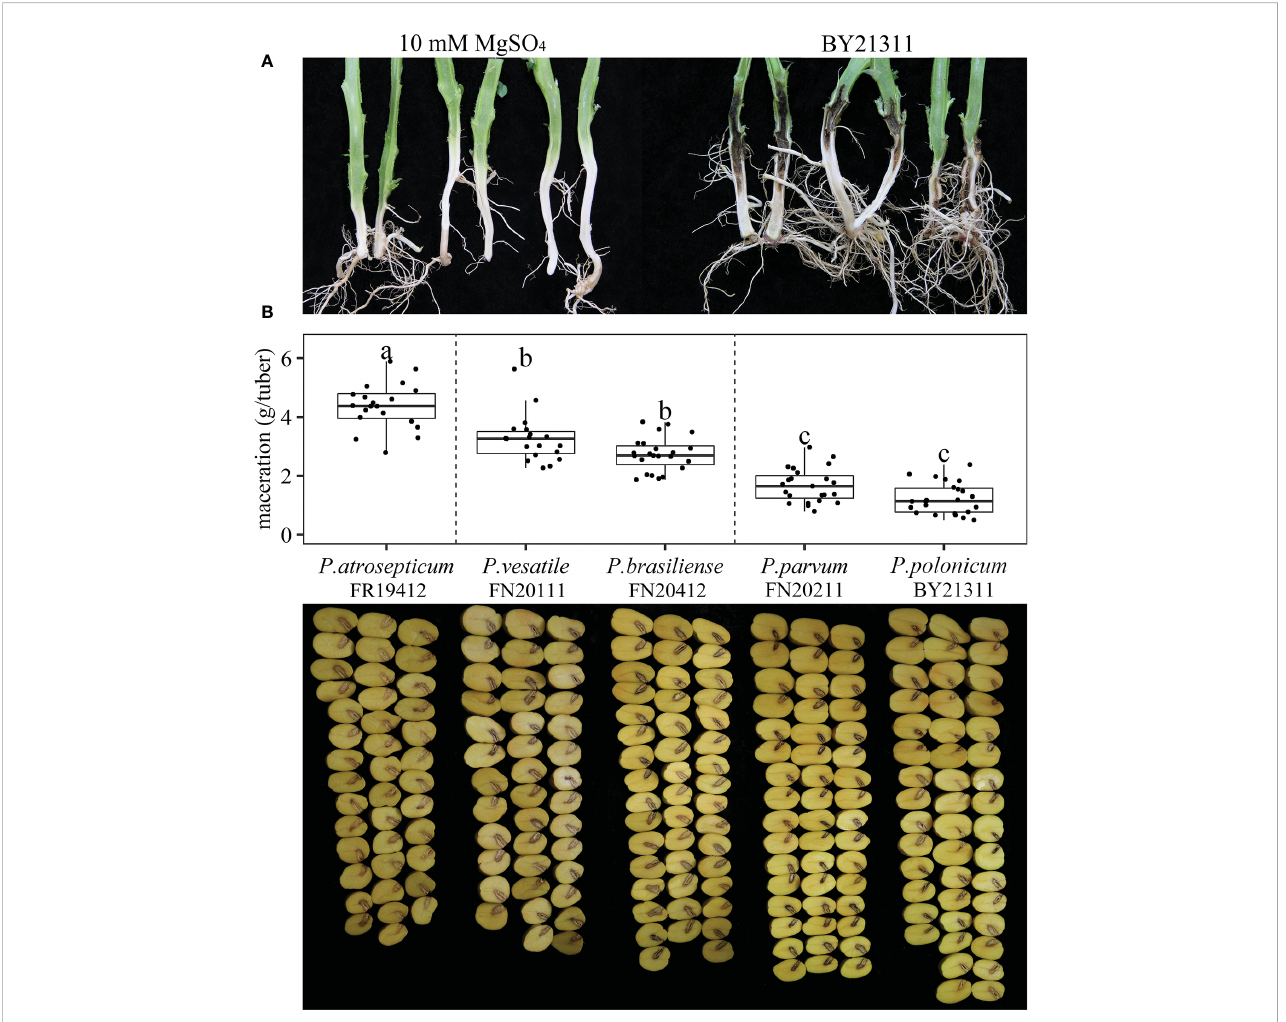
FIGURE 3 Pathogenicity test of Pectobacterium polonicum isolate BY21311 on potato stems and maceration assays of Pectobacterium species on potato tubers. (A) Potato stems were inoculated with isolate BY21311, and 10 mM MgSO4 solution was used as buffer control. Stems were cut open at two weeks after inoculation. (B) Washed and surface sterilized potato tubers were inoculated with Pectobacterium species. Tubers were cut open at 72 hours after inoculation. Boxplot showing variations in maceration ability on potato tubers among P. atrosepticum isolate FN20412, P. versatile isolate FN20111, P. brasiliense isolate FR19412, P. parvum isolate FN20211 and P. polonicum isolate BY21311. The black dots in each category (box) represent